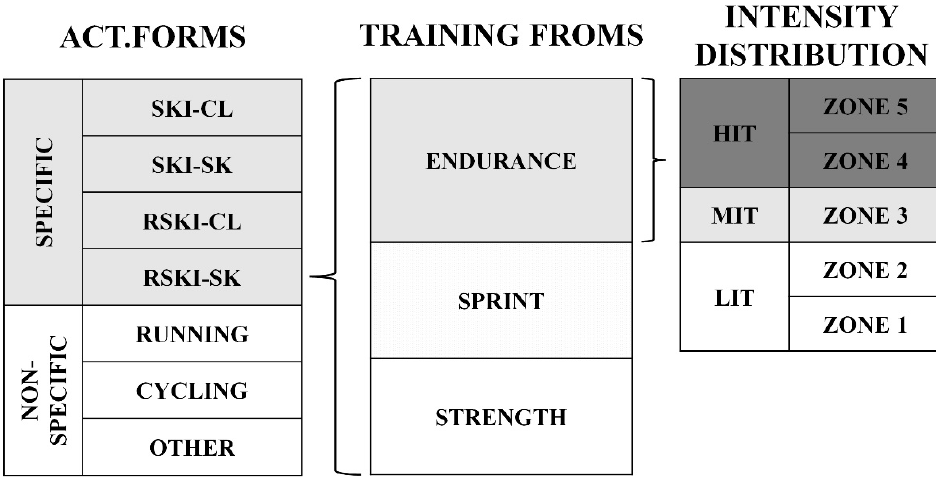
Figure 2. Training distribution methods. abbreviations: ACT. FORMS = activity forms.